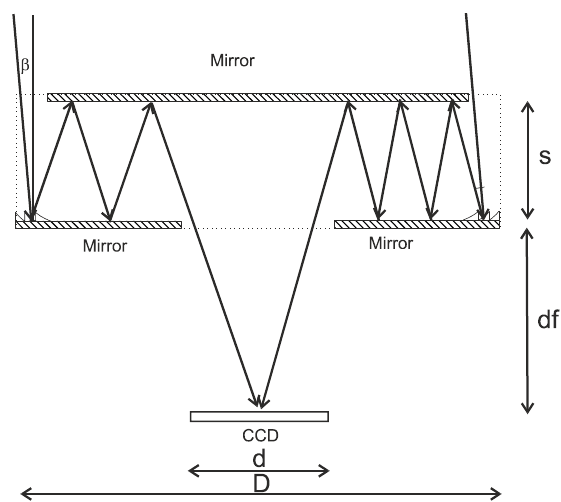
Figure 3. Incidence of a tilted beam with a different number of reflections.